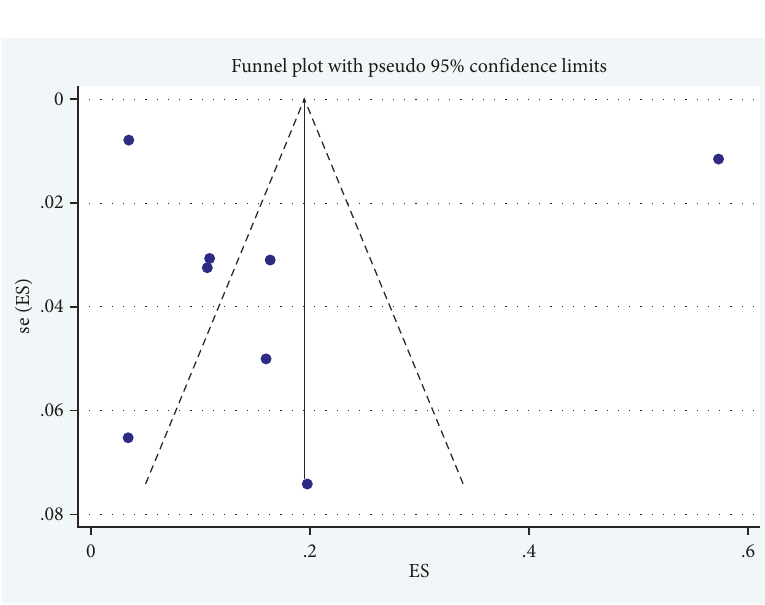
Figure 3: Meta-analysis of AR in COVID-19 cases of stay funnel